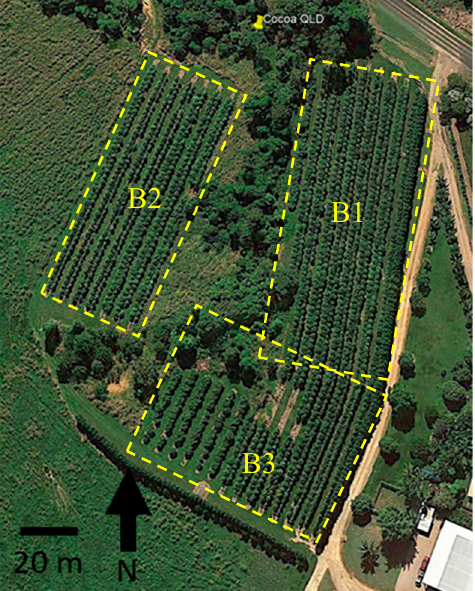
Figure 1. Aerial image of a cocoa plantation close to harvest from Mt Edna Maria Creeks, Queensland, Australia (Google Earth Pro ™ ). Yellow dotted lines show the blocks used, numbered from 1 to 3.